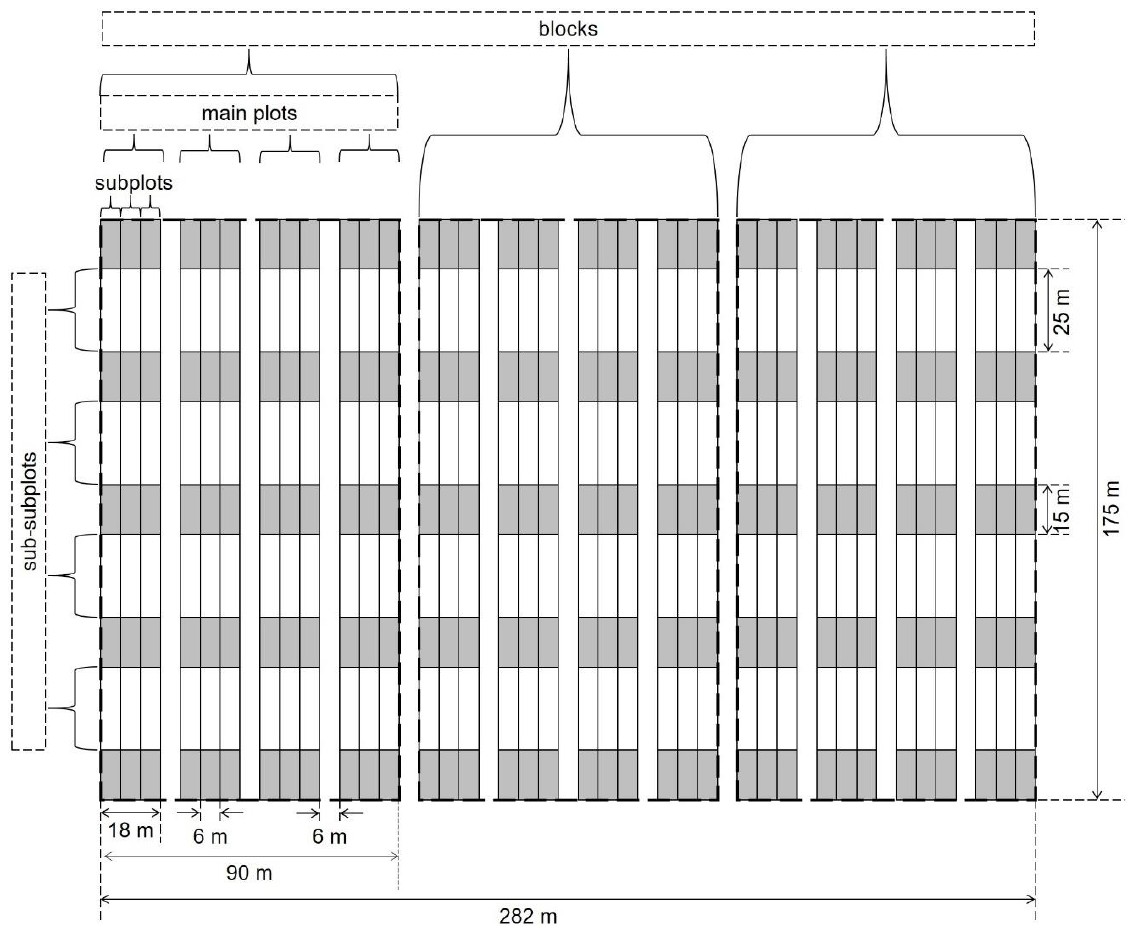
Figure 1. Schematic structure of the experimental design. The subplots’ boundaries were surveyed prior to harvesting using the SST FieldRover II 10.4 (SST Development Group Inc., Stillwater, OK, USA) surveying software, which stores GPS positioning data transmitted by the RTK-GPS rover (AgGPS 442; Trimble